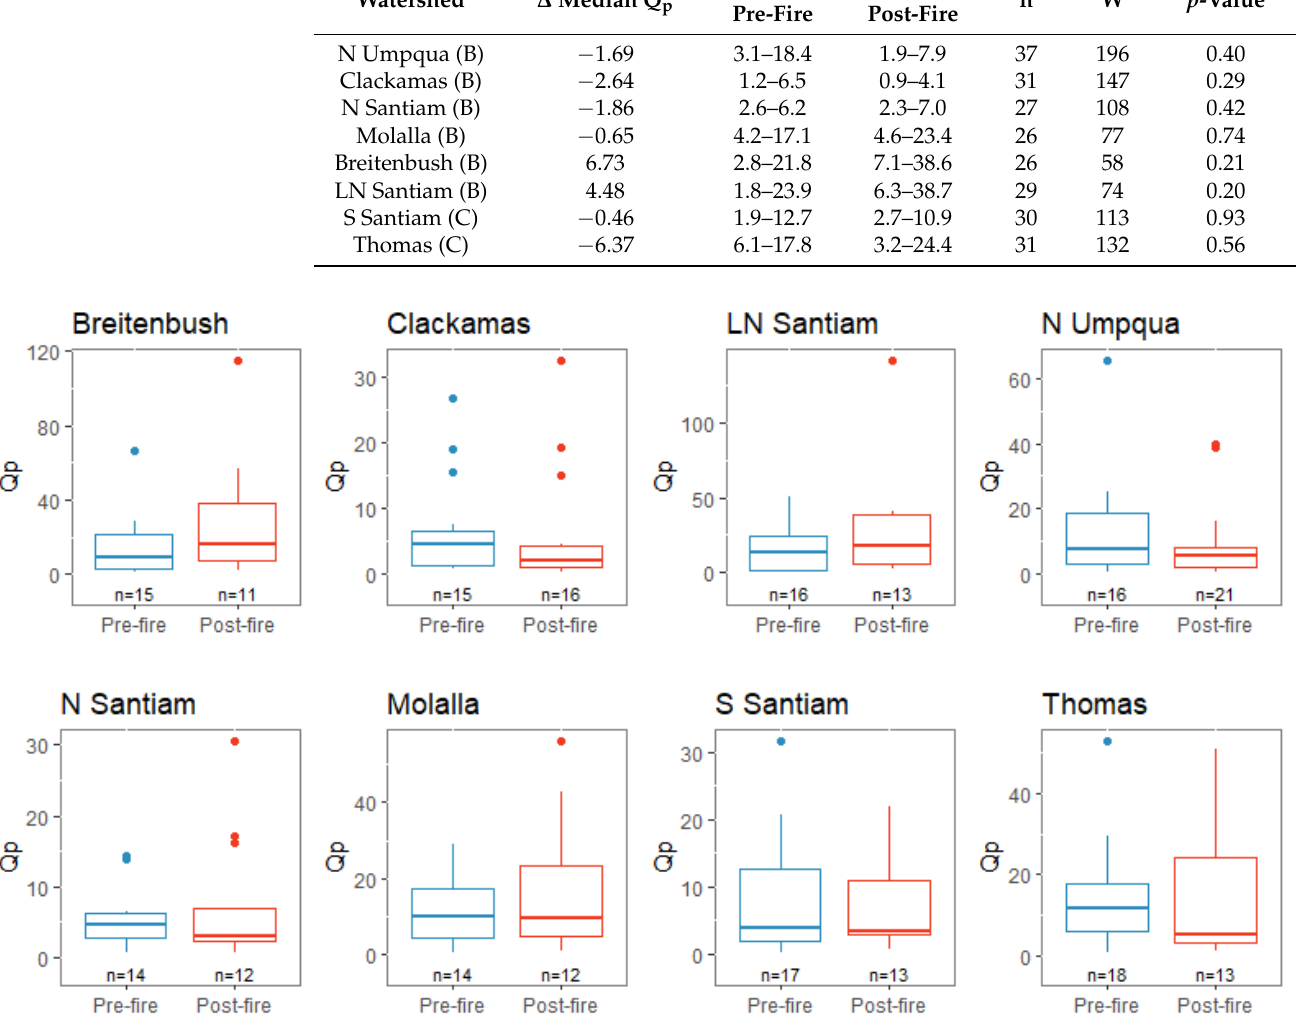
Figure 5. Box whisker plots of Q p values and for pre-fire and post-fire periods for eight Oregon Cascade Cascade watersheds.